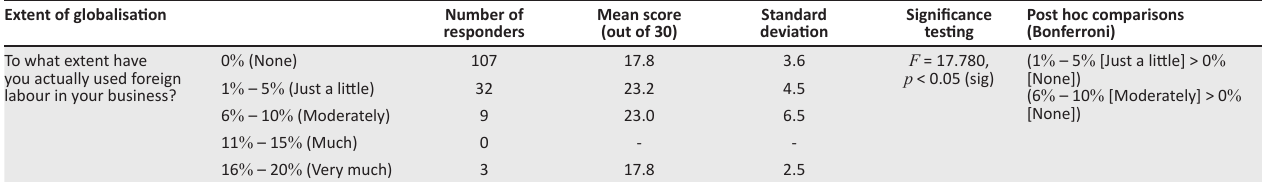
TABLE 5: Comparison of mean scores on the ‘influence of internationalisation’ index, by the extent of foreign labour usage. Extent of globalisation Number of